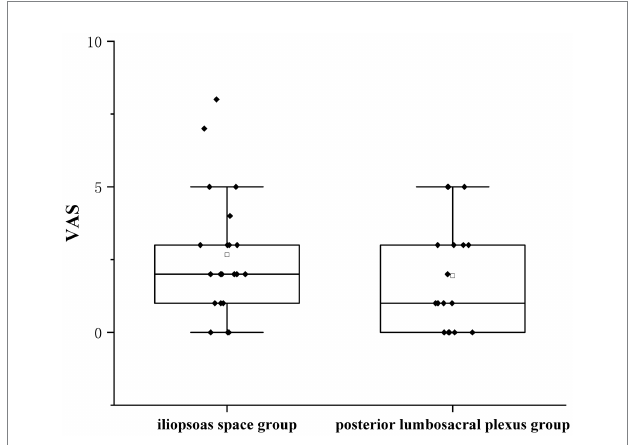
FIGURE 4 Effect of either an anterior iliopsoas space or posterior lumbosacral plexus block on postoperative pain after hip surgery with an injection of 0.33% ropivacaine. Data are expressed as median [interquartile range]. The 95% confidence intervals for the estimated group differences were prespecified tolerances and therefore deemed equivalent. VAS, visual analogue scale.